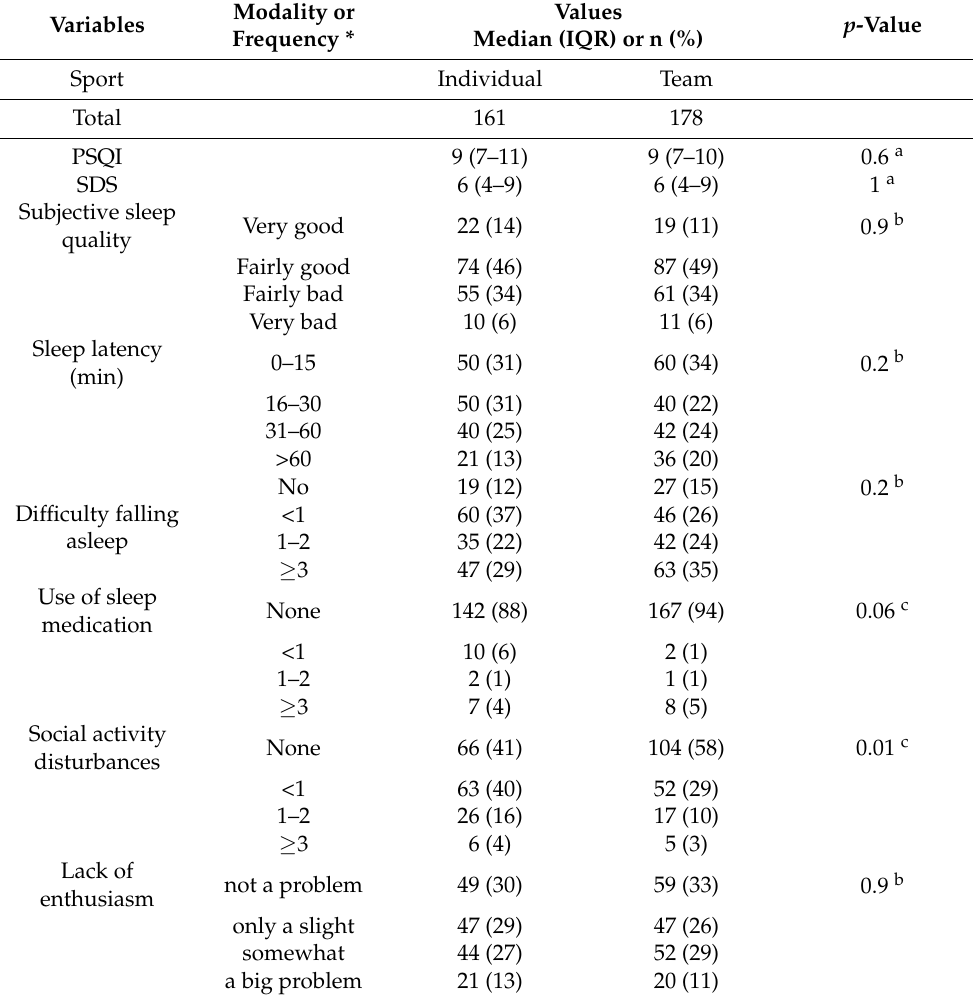
Table 3. Sleep characteristics based on sports